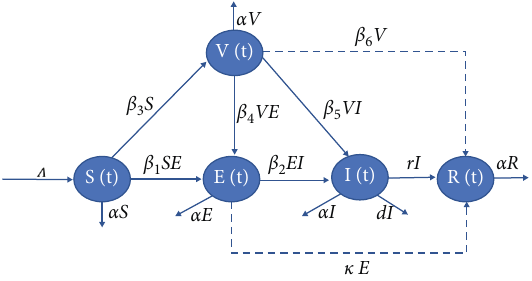
Figure 1: Flow chart of the model